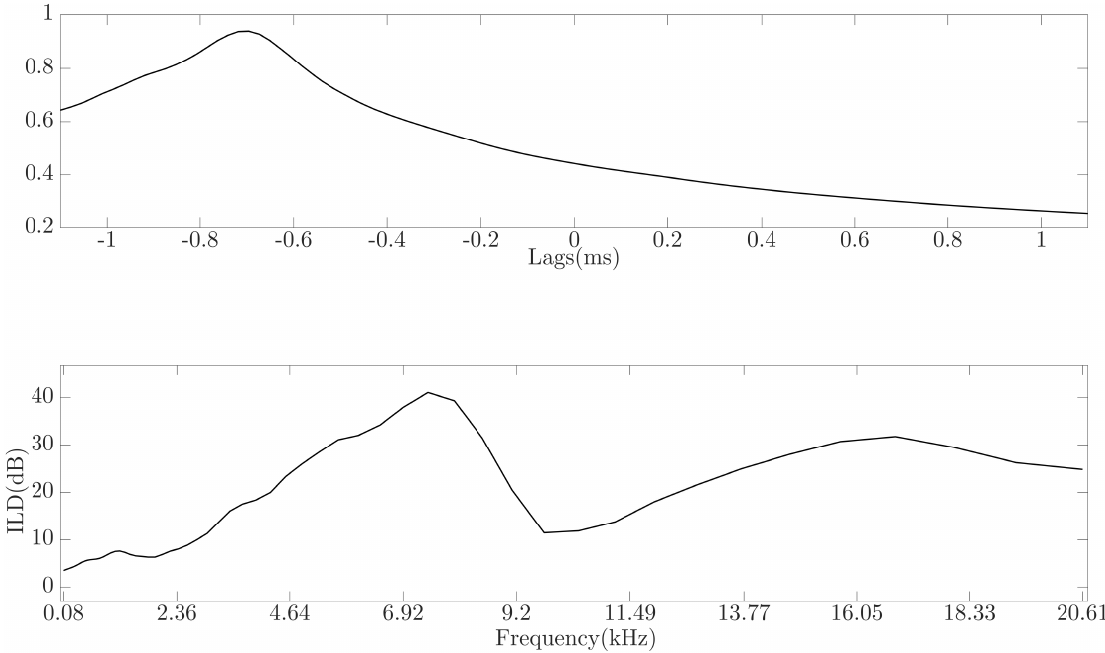
Figure 1. Example of the interaural cross-correlation function ( top ) and interaural level difference ( bottom ) for a HRIR with a source positioned at azimuth = 90 ◦ and elevation = 0 ◦